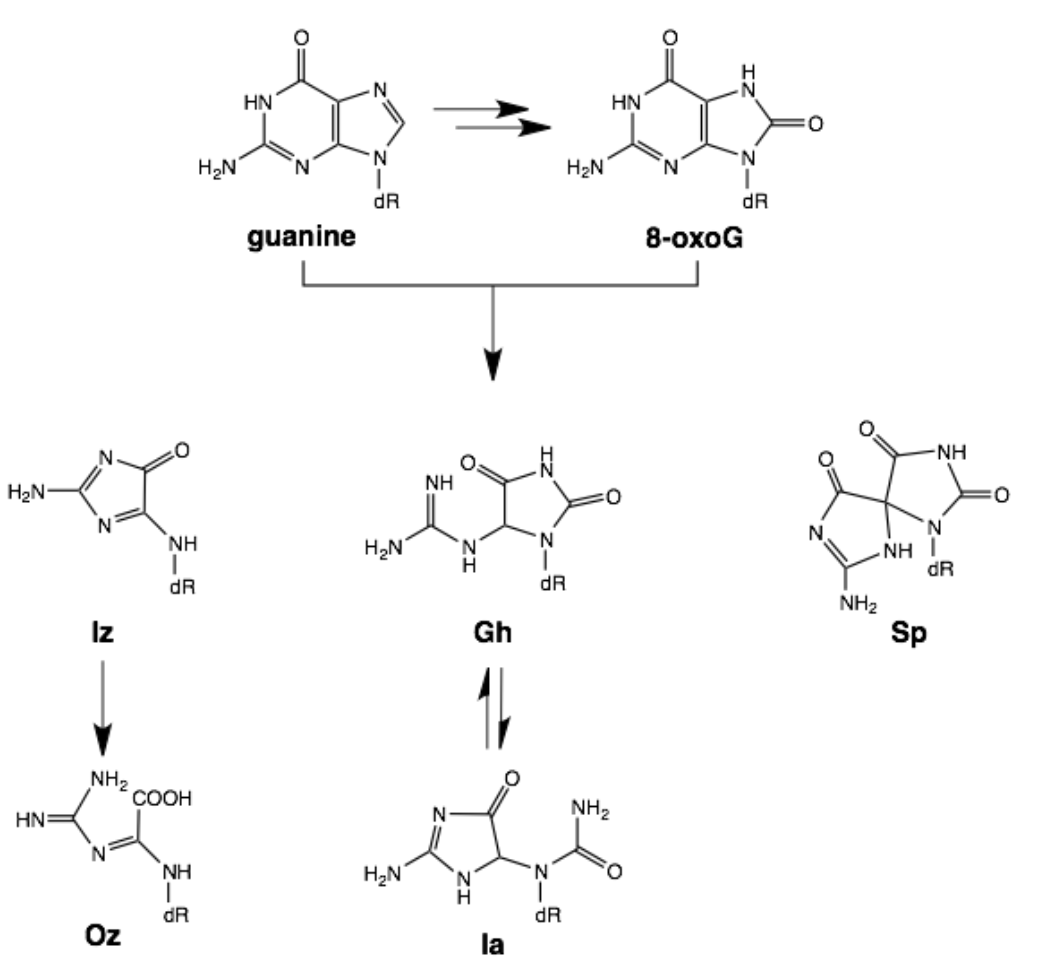
Scheme 1. Oxidation products of